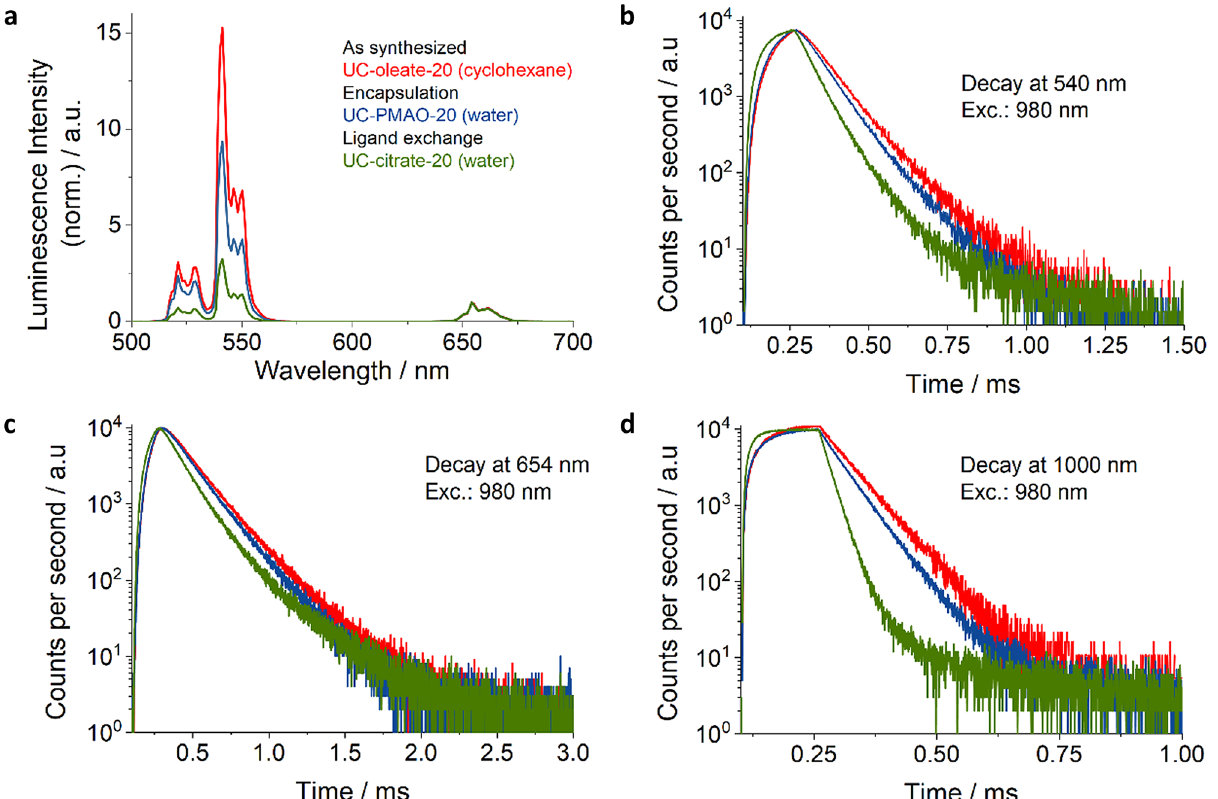
Figure 3. Luminescence properties of the differently coated hydrophilic UCNPs modified via encapsulation (blue) and ligand exchange (green) compared to the as-synthesized hydrophobic UCNPs. ( a ) Photoluminescence spectra measured at an excitation power density ( P ) of 22 W/cm 2 using a 980 nm laser diode; the spectra were normalized at 654 nm. ( b ) Lifetime of the Er 3+ upconversion luminescence (UCL) excited at 980 nm ( P of 67 W/cm 2 ; pulse width 40 µs) and recorded at 540 nm; ( c ) Lifetime of the Er 3+ UCL excited at 980 nm ( P of 128 W/cm 2 ; pulse width 40 µs) recorded at 655 nm; and d) Lifetime of the downshifted